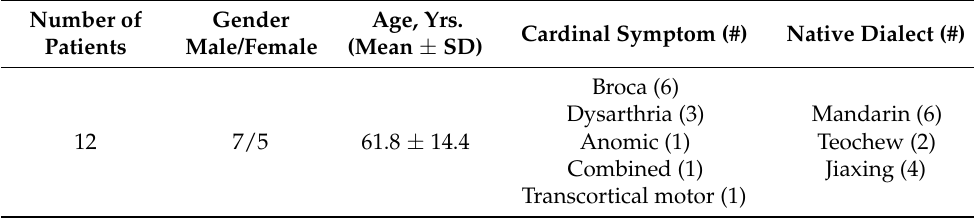
Table 3. Aphasic patients’